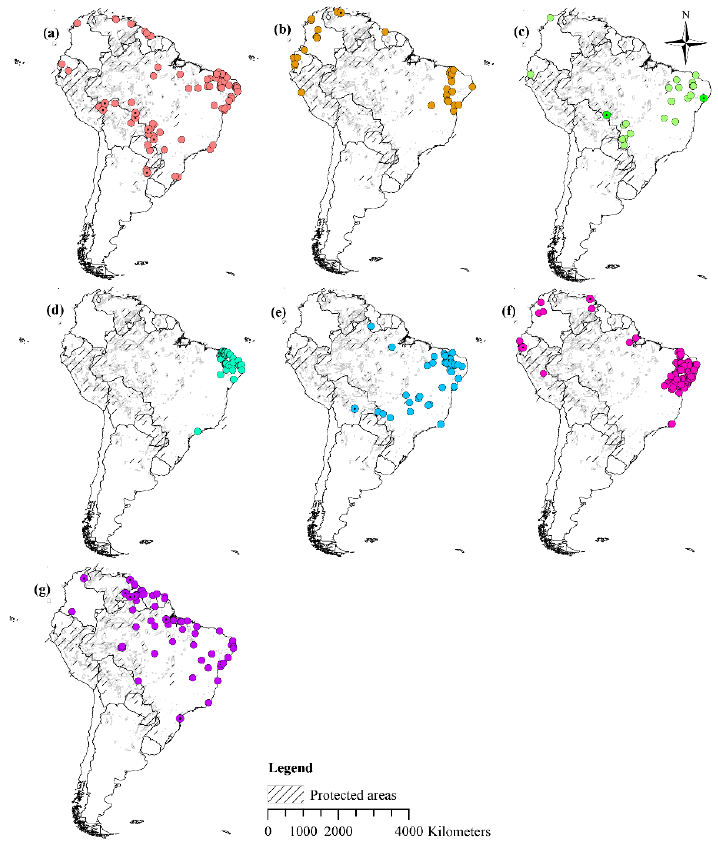
Figure 1. Occurrence points for the seven water lily ( Nymphaea ) species in South America: ( a ) N. amazonum , ( b ) N. ampla , ( c ) N. jamesoniana , ( d ) N. lasiophylla , ( e ) N. lingulata , ( f ) N. pulchella , and ( g ) N. rudgeana . The points marked with a black dot inside indicate occurrence points within protected areas.